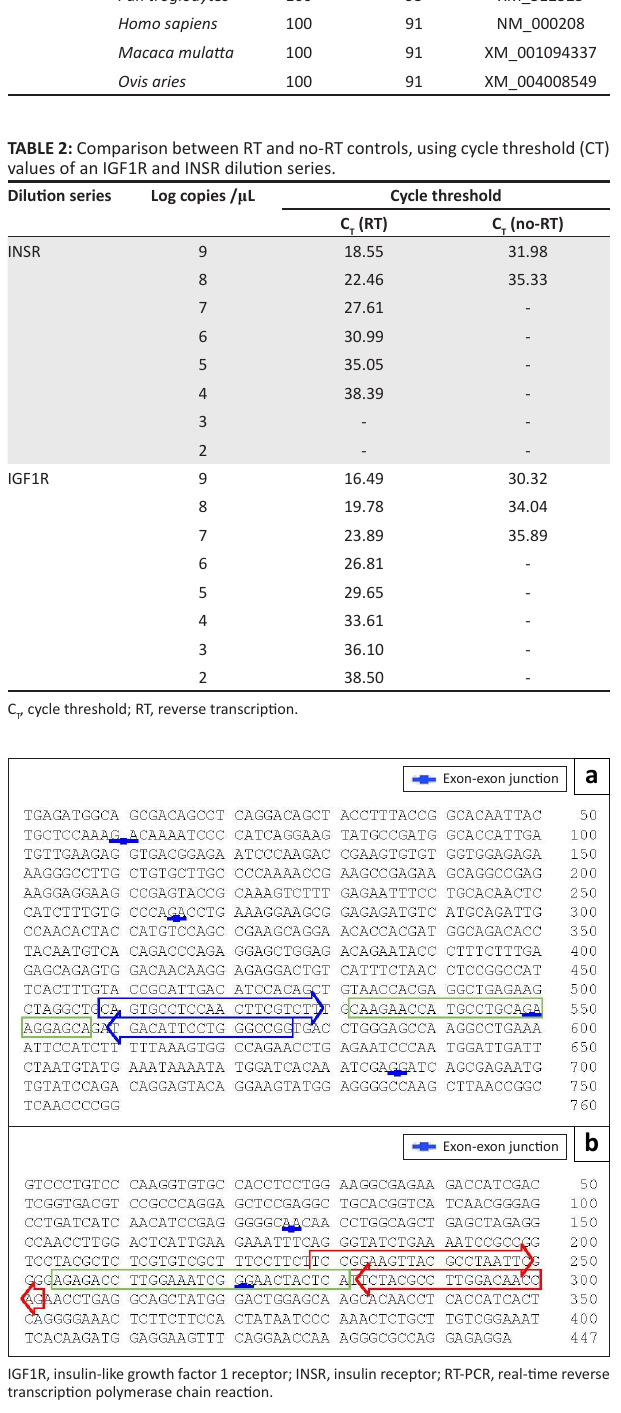
FIGURE 2: Location and sequence of primers (arrows) and TaqMan® TAMRA™ probes (blocks) designed for quantification, (a) IGF1R and (b) INSR by real-time